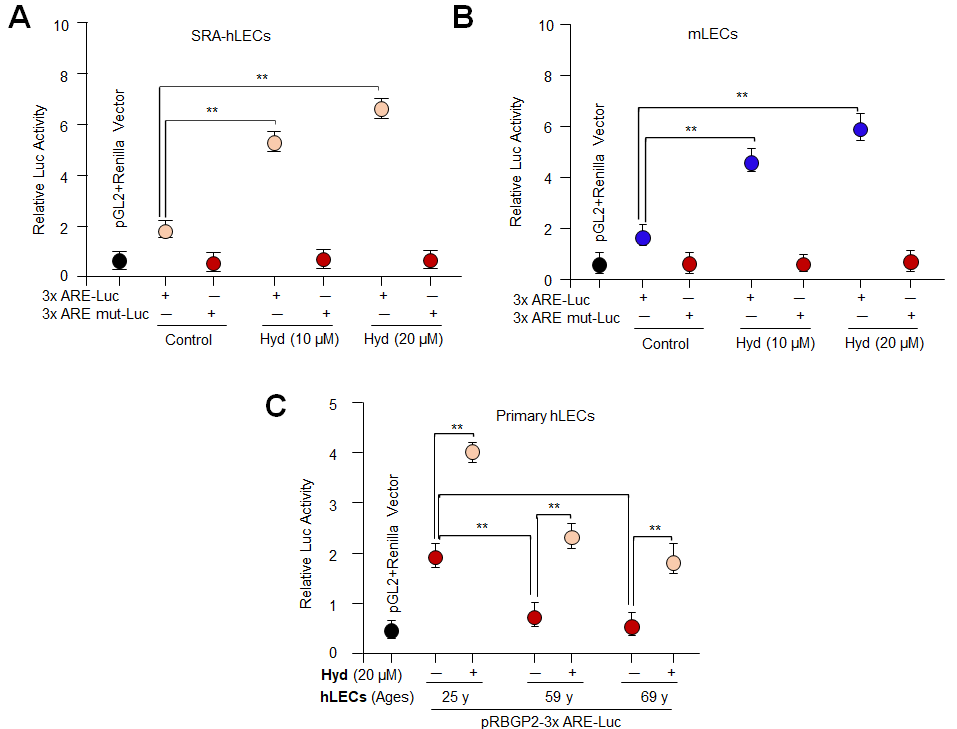
Figure 3. Hyd-activated antioxidant gene transcription via Nrf2/ARE in general; Engineered luciferase promoter containing 3x ARE sites suggested that Hyd activated the Nrf2-dependent transcription through ARE sequences in LECs. ( A , B ) SRA-hLECs ( A ) and mLECs ( B ) were transiently transfected with pRBGP2-3xARE-LUC plasmid or its mutant at all three ARE sites. Then, 14 h later, the transfected LECs were treated with different concentrations of Hyd for 24 h, as indicated. Relative LUC activity was observed. The data represent the mean ± S.D. from three independent experiments. ** p < 0.001. ( C ) Progressive decline in Nrf2/ARE-mediated transcription with advancing age was reactivated by Hyd treatment. Primary hLECs of different age groups were transiently transfected with pRBGP2-3xARE-LUC plasmid. At 14 h of post-transfection, hLECs were treated with Hyd (20 µ M) for 24 h as indicated, and relative LUC activity was quantified. The data represent the mean ± S.D. values obtained from three independent experiments. ** p <